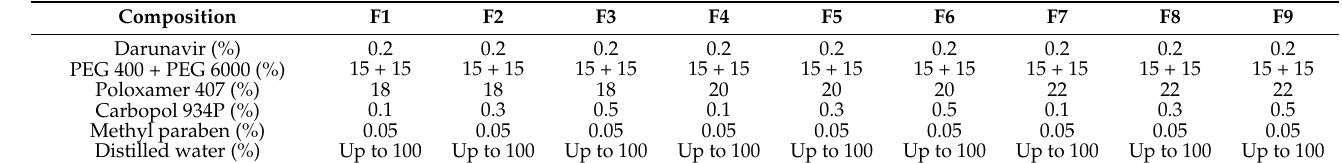
Table 1. Compositions of preliminary batches of nasal in situ gel of darunavir.